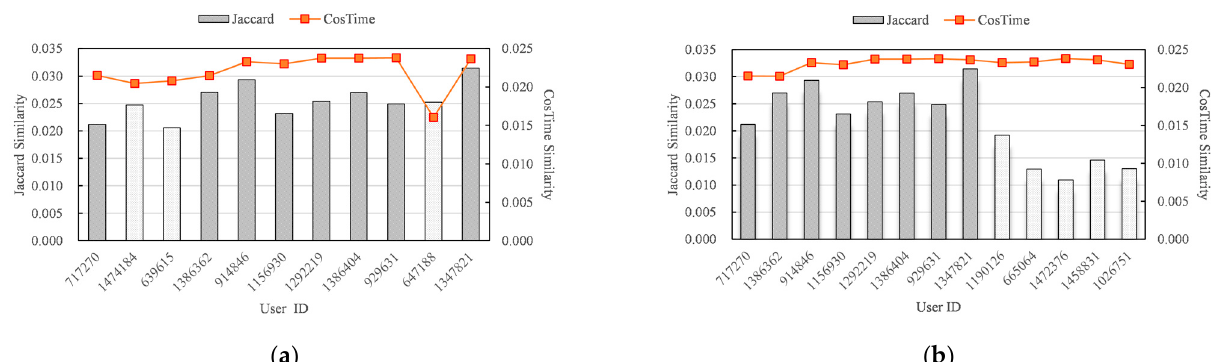
Figure 3. Comparison of community nodes queried by different models. ( a ) Nodes in H vac community and their similarity with q ; ( b ) nodes in H twc community and their similarity with q